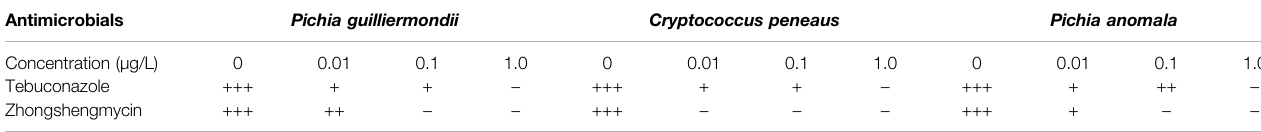
Zhongshengmycin